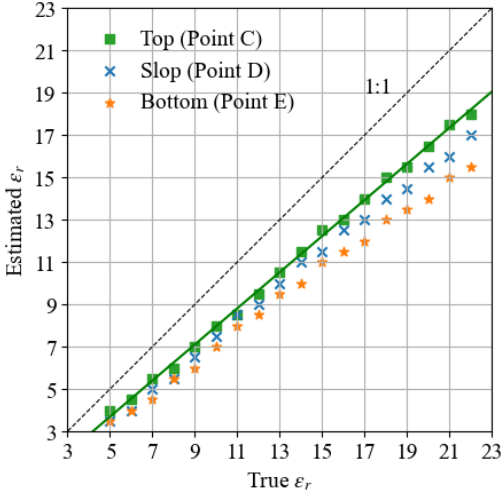
Figure 5. Inversion results for Configuration ii, with the source/receiver situated above the hill, slope and the trench,